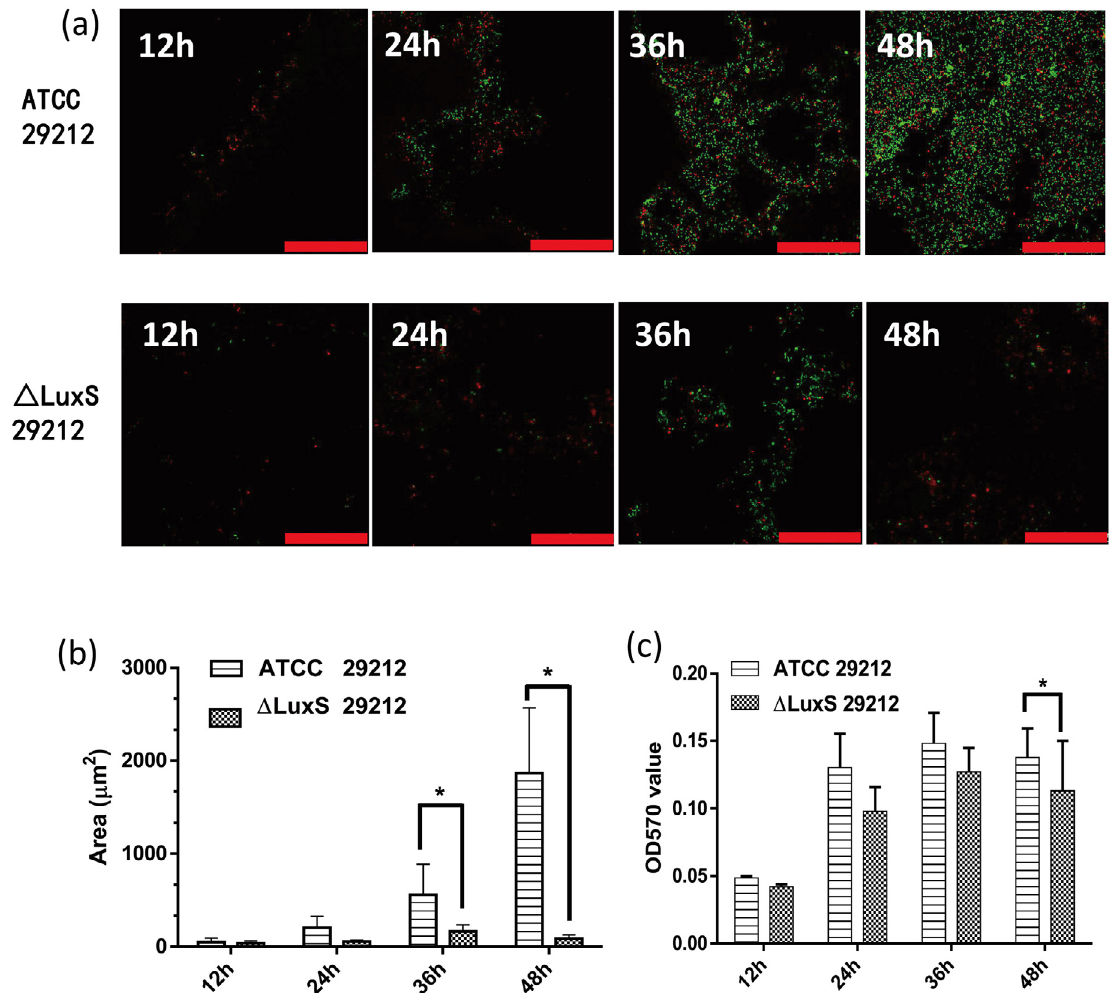
Figure 5- The deletion of LuxS gene decreased the biofilm formation ability of E. faecalis . (a) Confocal laser scanning microscope images of biofilm formation on Δ LuxS E. faecalis strain at 12 h, 24 h, 36 h and 48 h. Scale bar=50 μm; (b) The biofilm areas were measured using an image-processing program; (c) Quantifying the biofilm by crystal violet staining, One-way ANOVA was used to analyze the statistical significance. All error bars signify standard deviation (n=3).